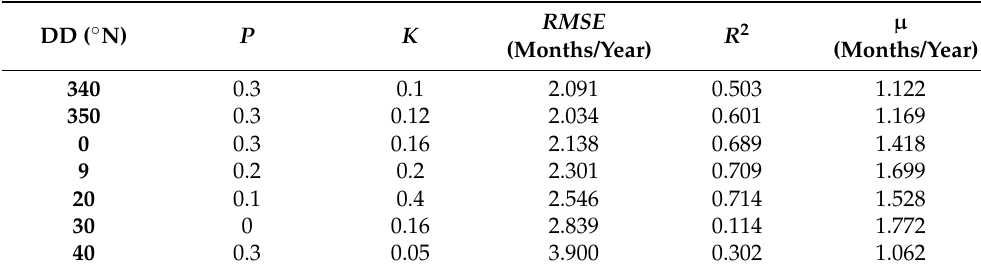
Table 2. Groin area performance indices ( RMSE , R 2 , and mean μ ) for the best scenario for the shifted direction.